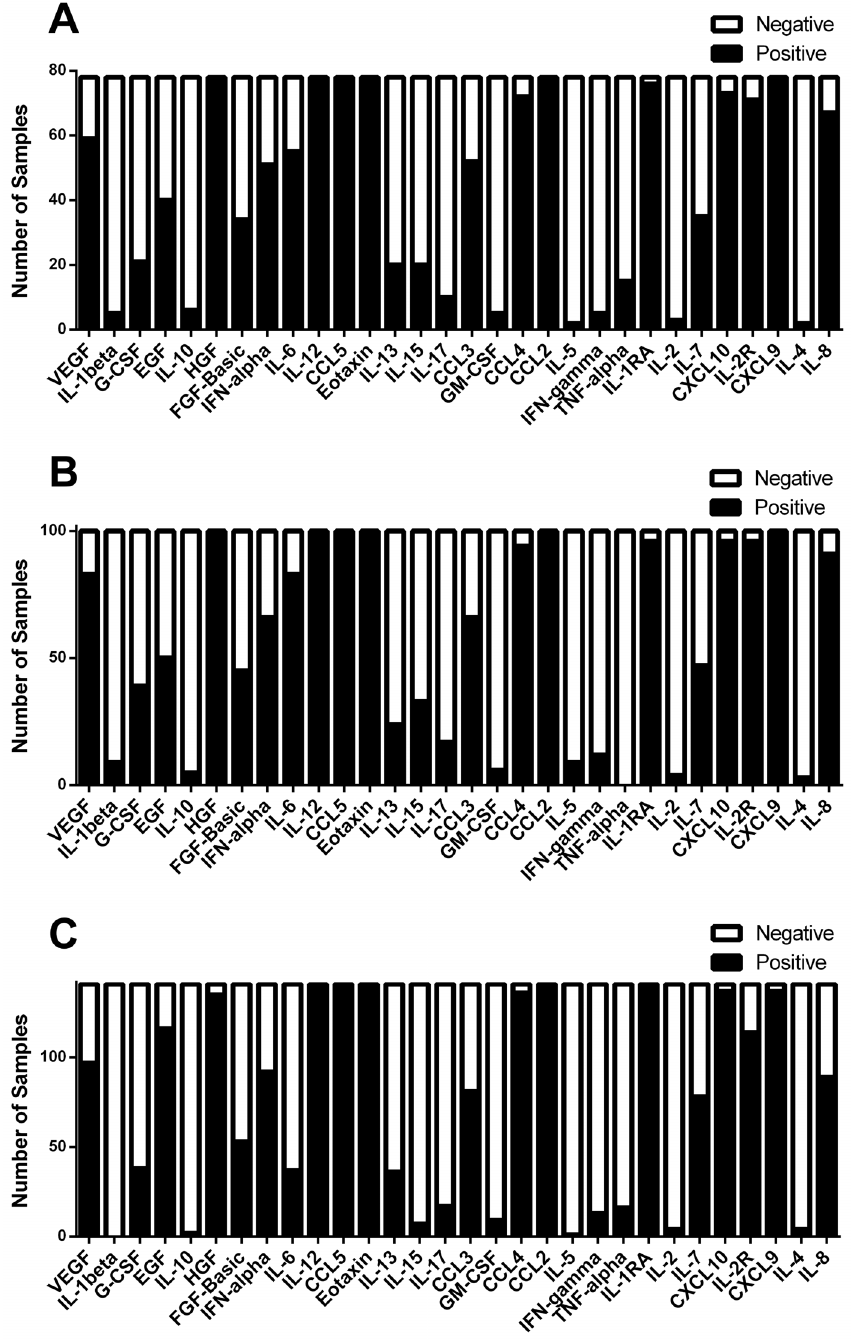
Figure 2. Detectability of circulating inflammatory mediators in Clostridiumdifficile infection (CDI). Results for cases (panel A), inpatient controls (panel B), and outpatient controls (panel C) are shown.